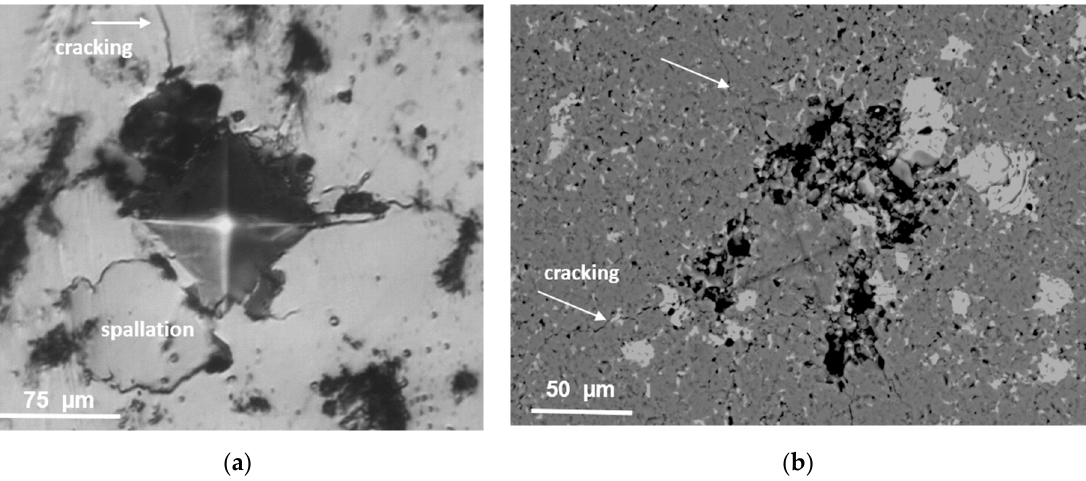
Figure 6. ( a ) Light microscopy image of the surface of the indented area: TiB 2 /10 Ti 5 Si 3 composite sintered at 1600 °C ( b ); SEM image of the surface of the indented area of the TiB 2 /20 Ti 5 Si 3 composite sintered at 1600 °C.